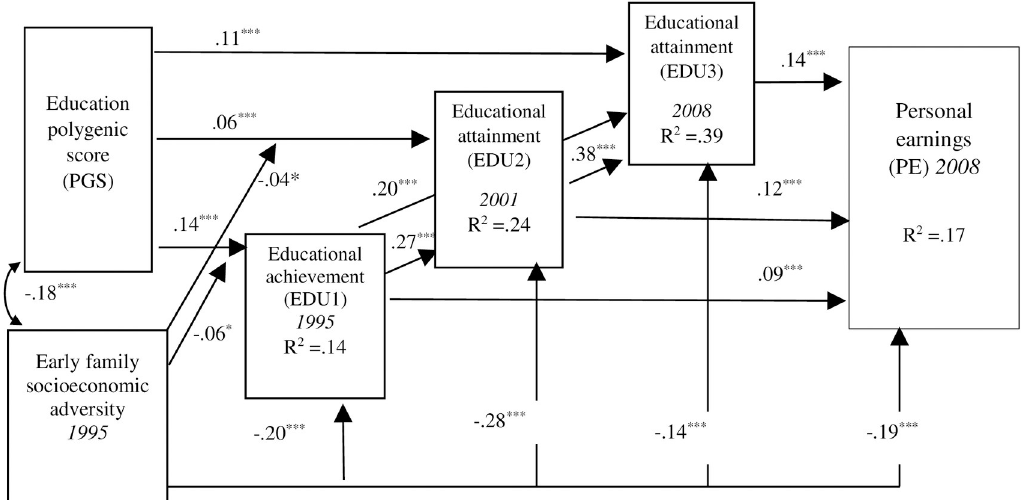
Fig 3. Model 2: Additive, cascading, and cumulative life course processes from family socioeconomic adversity and PGS. Note. Age was significantly associated with ED1, ED2, ED3, and PE (-.21, .27, .20, and .07, respectively, p < .05). Gender (female) was significantly associated with EDU1, EDU2, EDU3, and PE (.07, .11, .08, and -.25, respectively, p < .05,). Standardized coefficients are shown. Non-significant paths are not shown. � p < .05. ��� p < .001. p < .001. CFI = .96. RMSEA =